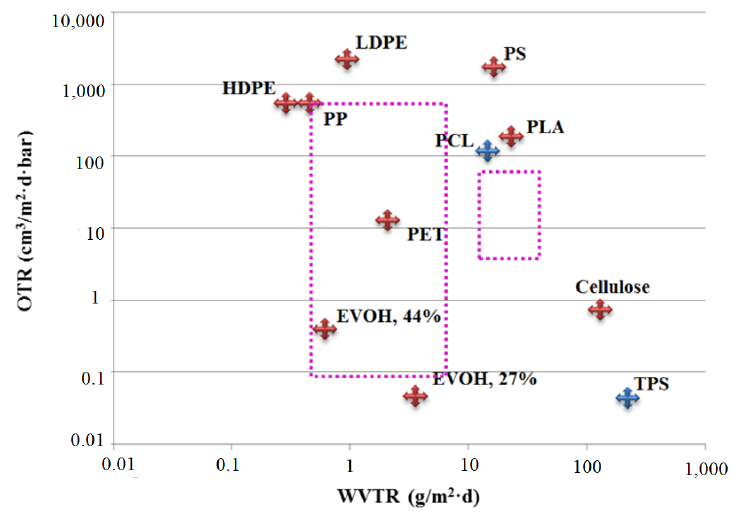
Figure 1. Comparison between barrier requirements of some food (dotted lines) and barrier properties of some plastics used in food packaging. WVTR and OTR values of materials are normalized at 100 µm of thickness. Reprinted with permission from Ref. [23]. Copyright 2017 Copyright Else- vier.